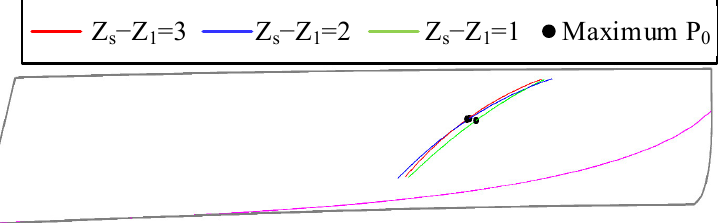
Figure 13. Contact paths of different tooth-number differences between the shaper and the pinion.